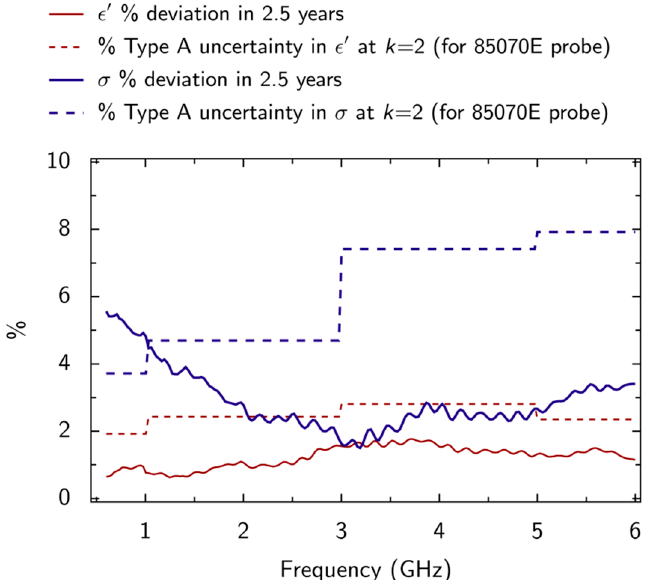
Figure 6. Observations of the effect of ageing (by a 2.5-year interval) on the dielectric properties ε ’ and σ of the broadband tissue-equivalent liquid. The observed Type A uncertainty associated with measurements made by using the 85070E 3.5 mm probe (Table 1) is also plotted for a coverage factor of k = 2 (equivalent to 95% confidence level).